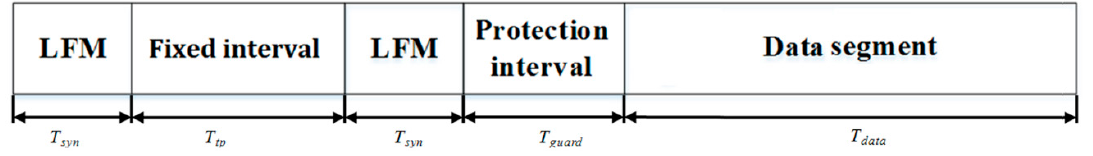
Figure 1. Block chart of the direct sequence spread spectrum (DSSS) demodulation. PN = Pseudo Noise.